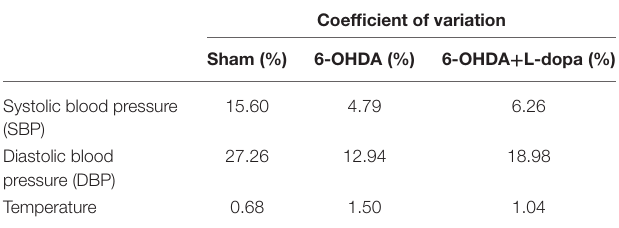
TABLE 2 | The coefficient of variation (CV) of the SBP, DBP, and temperature in the sham group, the 6-OHDA-lesioned group, and the 6-OHDA-lesioned + L-dopa